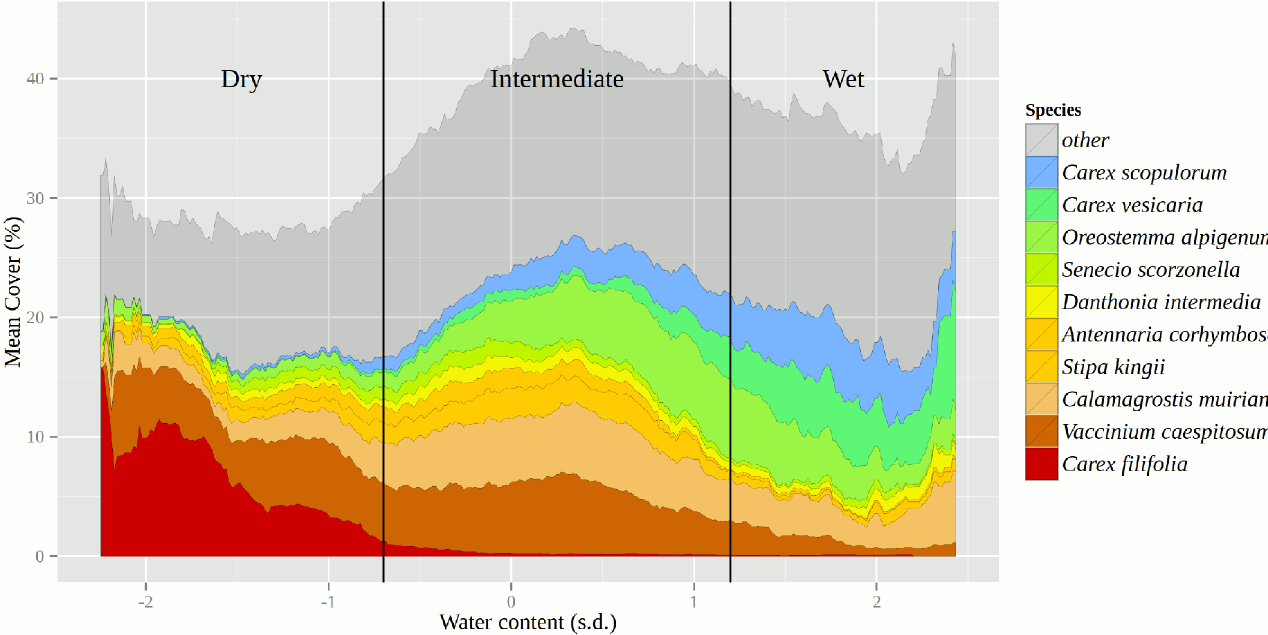
Fig 2. Moving averagesof cover (%) for the 10 most dominant plant species along a gradient of soil volumetric water content (Water content) across all species plots (n = 1322). Shadedbackground represents moving averagecover for all species present. Soil water content values are expressedas standard deviations (s.d.) from individualmeadowmeans. Valuesrun from driest plots on left (-3.0) to wettest plots on right (3.0). The moving averagewindowwidth = 0.25 s.d. Vertical lines indicate breaks used to delineateindividualvegetationcommunity types (Dry, Intermediate, and